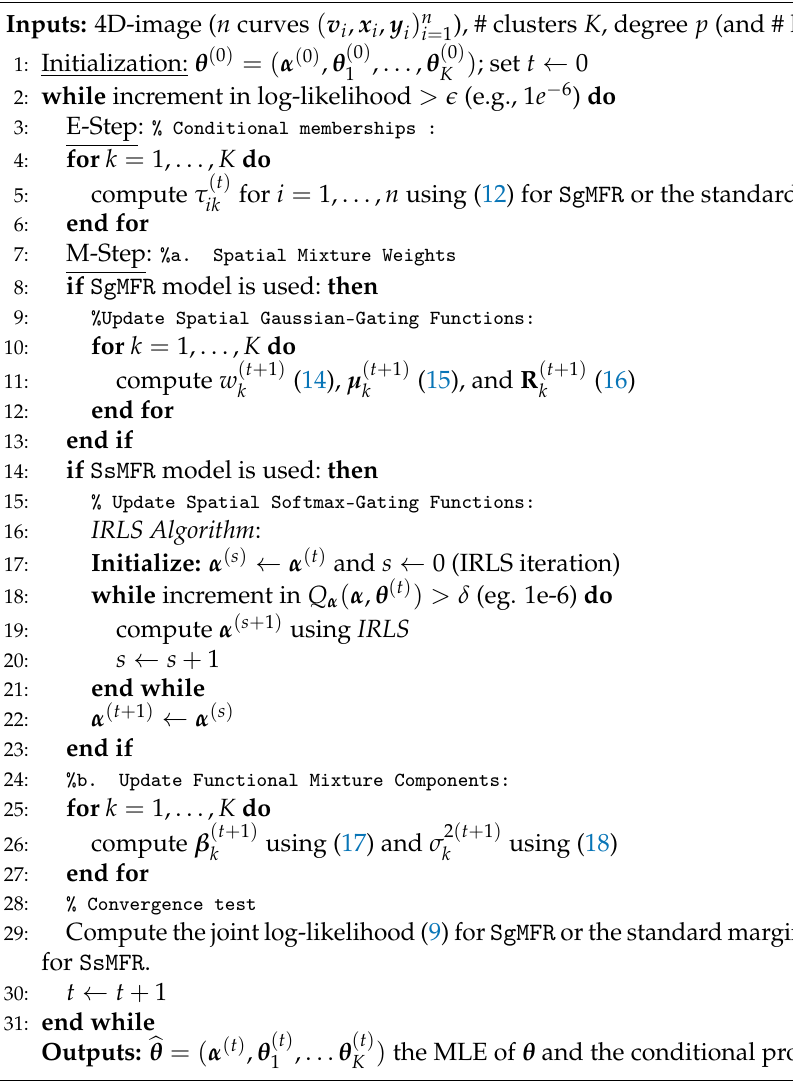
Algorithm A1 Pseudo code of DECT-CLUST with SsMFR and SgMFR